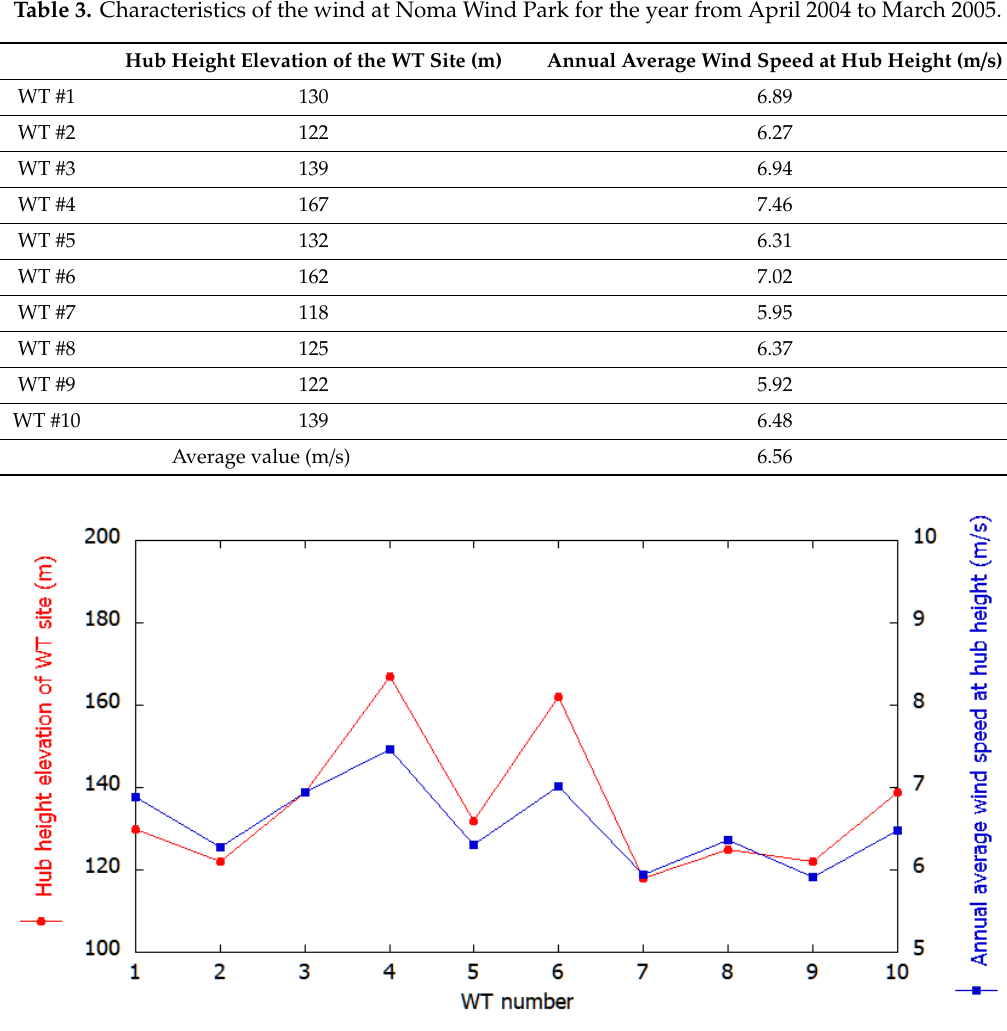
Figure 16. Relationship between the hub height elevation and annual average wind speed at hub height for the year from April 2004 to March 2005.